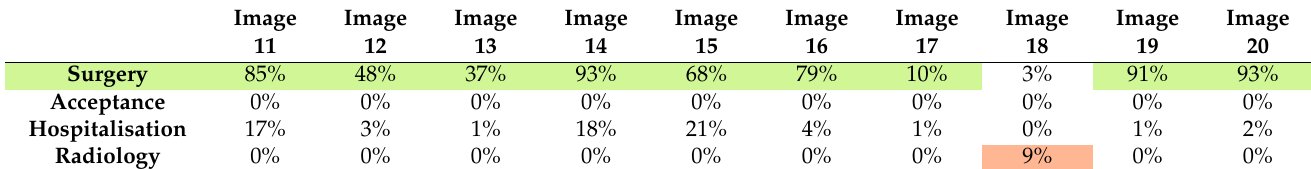
Table 8. Results obtained with the second version of the customised model for the “surgery” IU. Each column refers to one of the test images (11 to 20) and each row shows the labels that were returned by the model. The row–column intersection shows the success rate in recognising the concept stated in the row for the image in that